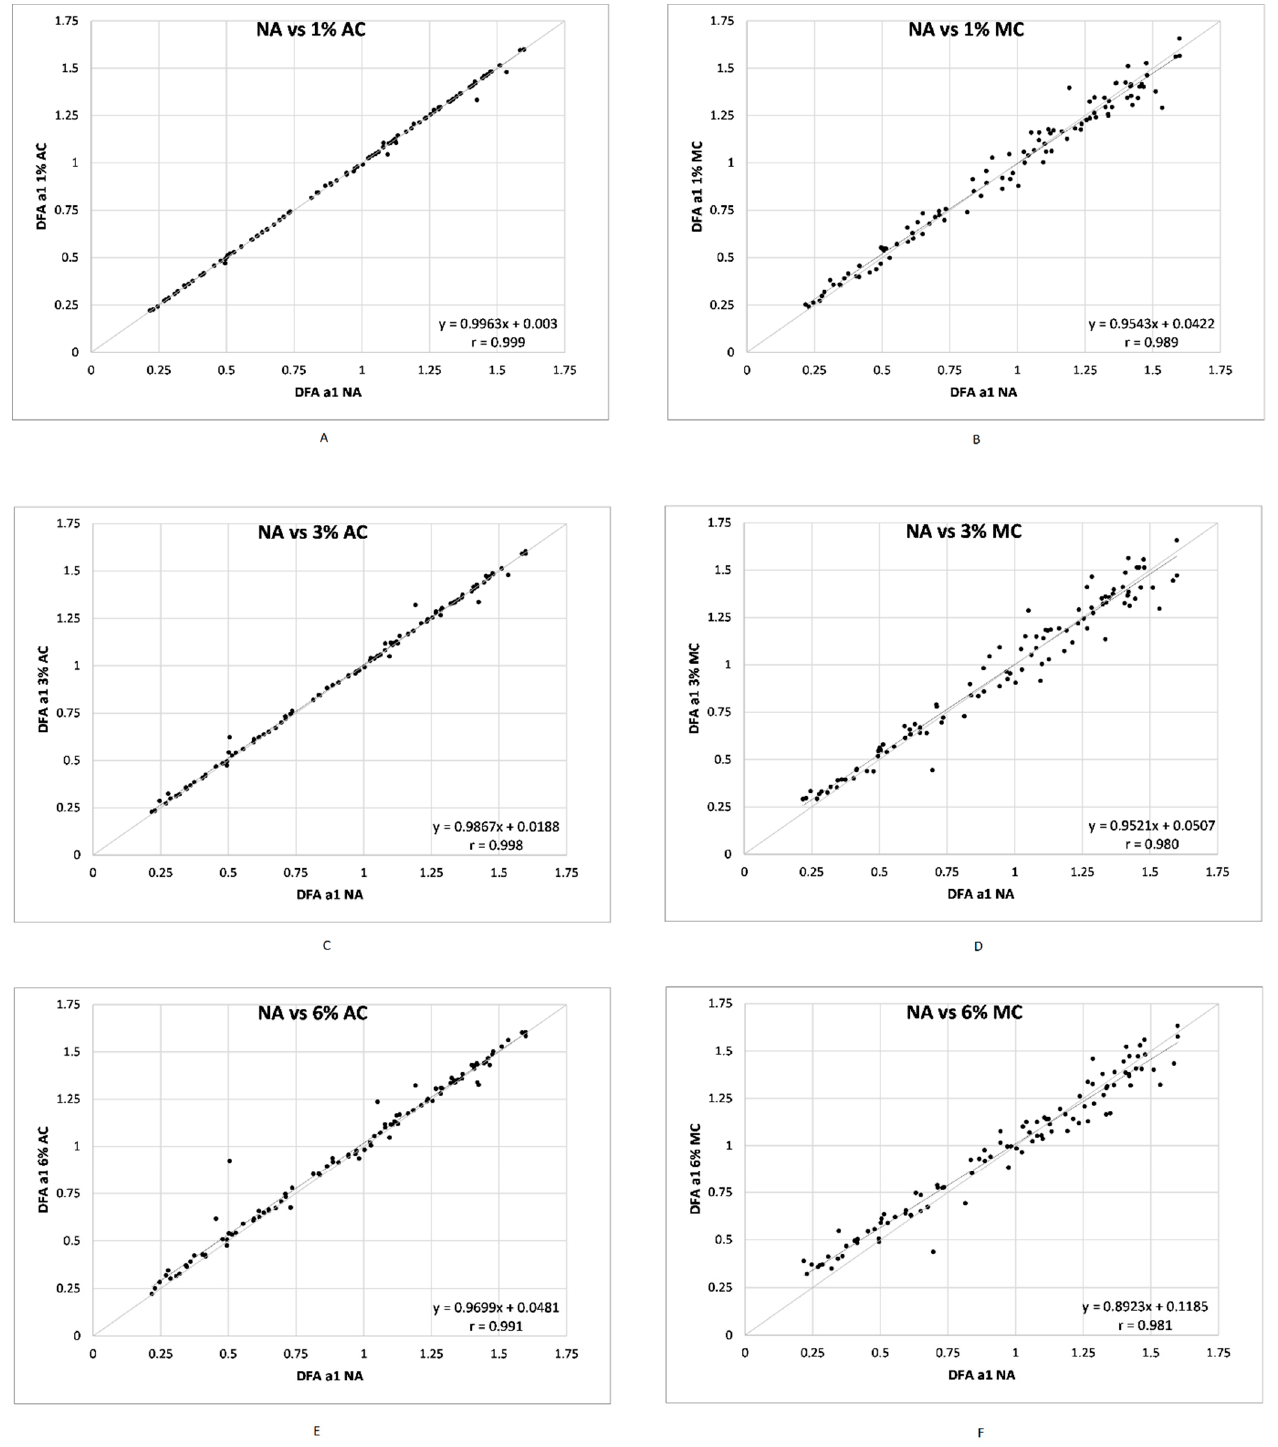
Figure 2. Regression plots for all ECG derived DFA a1 NA vs. DFA a1 for each artefact condition and correction method. ( A ) vs. DFA a1 1% AC; ( B ) vs. DFA a1 1% MC; ( C ) vs. DFA a1 3% AC; ( D ) vs. DFA a1 3% MC; ( E ) vs. DFA a1 6% AC; ( F ) vs. DFA a1 6% MC. Bisection lines in light gray. Slope and Pearson’s r shown in bottom right of each plot.